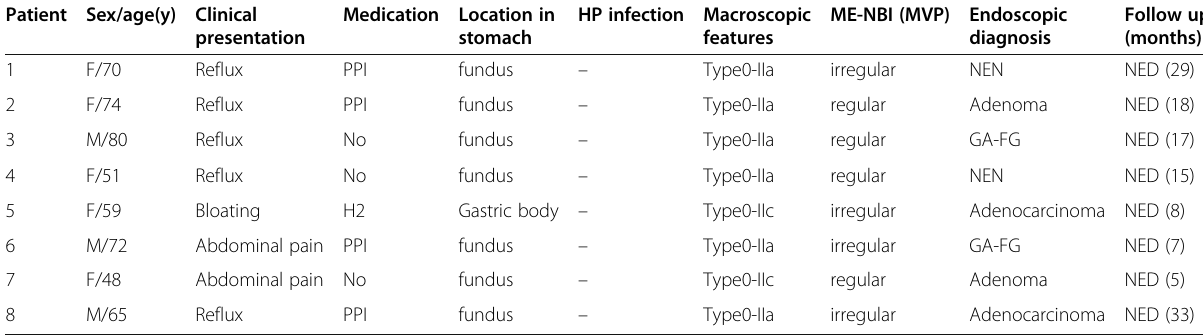
Table 1 Clinical features in eight patients with GA-FG by ESD Patient Sex/age(y) Clinical presentation